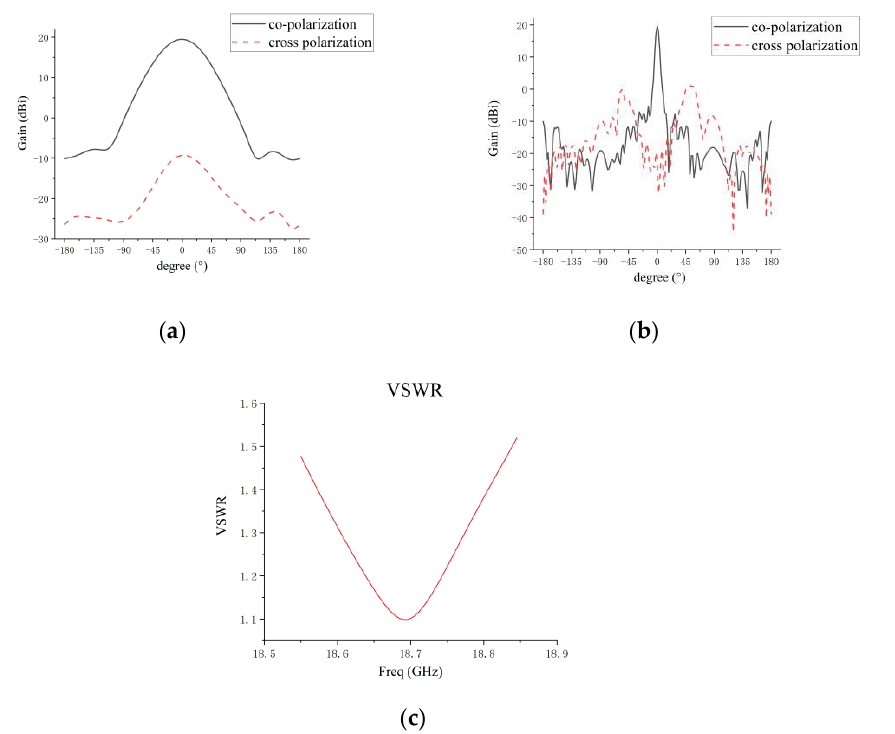
Figure 4. ( a ) Simulated results of E-plane pattern; ( b ) simulated results of H-plane pattern; ( c ) sim- ulated results of VSWR. lated results of